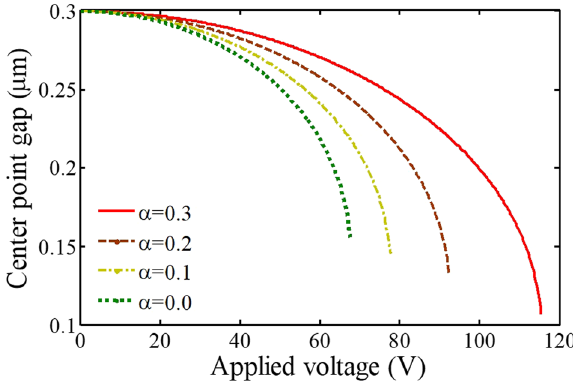
Figure 3. The impact of adherent biological particles on the sensor behavior (T = 300 K).